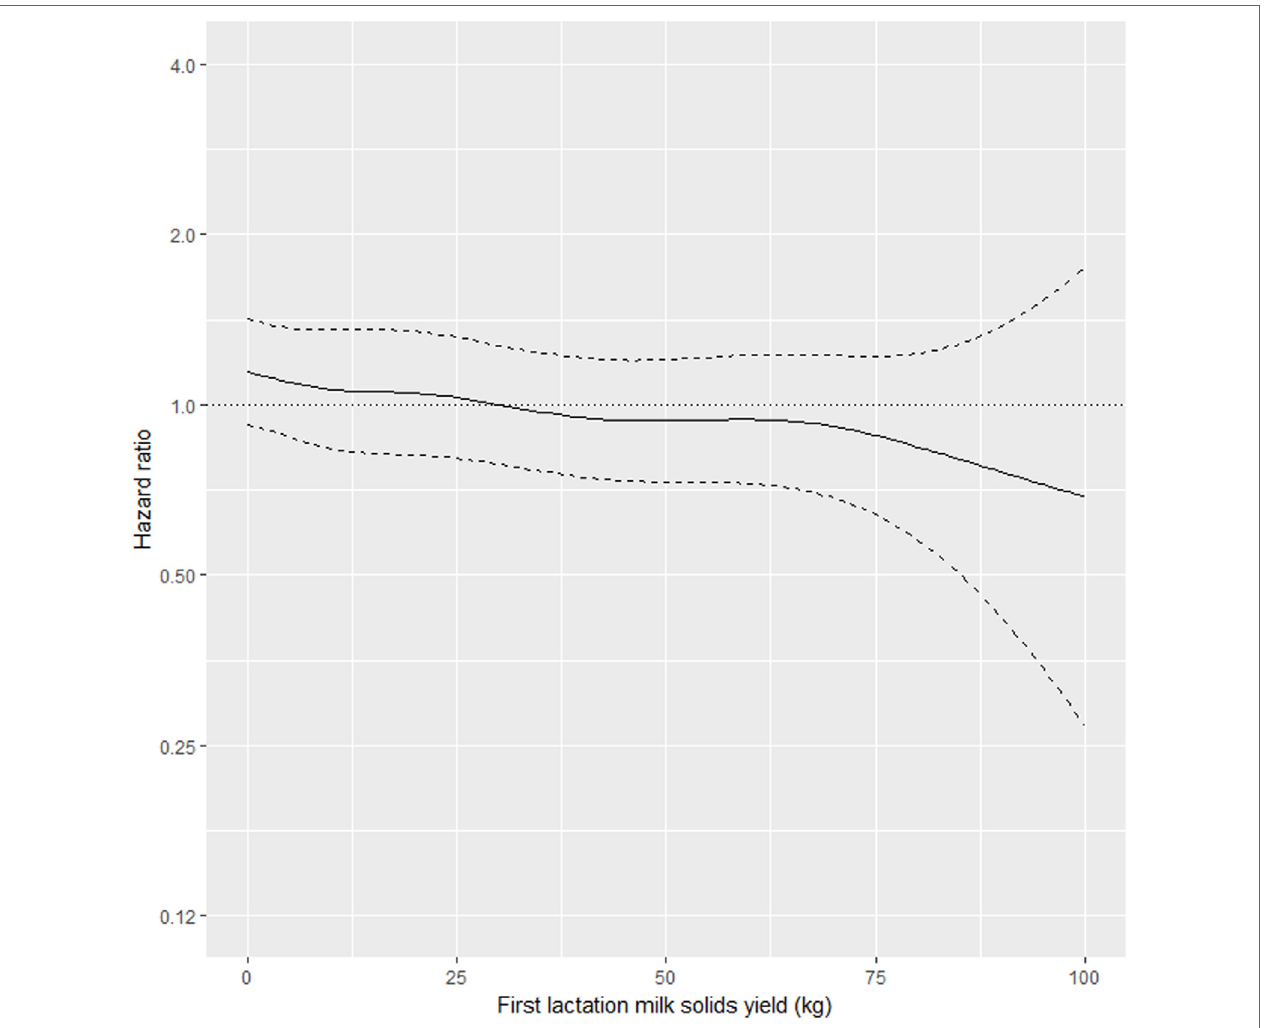
FigUre 2 | Risk factors for culling, sales and deaths in New Zealand dairy goat herds, 2000–2009. Line plot showing, for the interval 0–730 days from the date of second kidding, the hazard ratio for removal as a function of first lactation milk solids yield (based on the model presented in Table 2 ). The dashed lines represent 95% confidence intervals around the point estimates of the hazard ratio. In the above plot, the reference category was a doe producing 30 kg milk solids in the first lactation. A doe producing 80 kg milk solids in the first lactation had 0.84 (95% CI 0.58–1.23) times the daily hazard of removal compared with a doe that produced 30 kg milk solids in the first